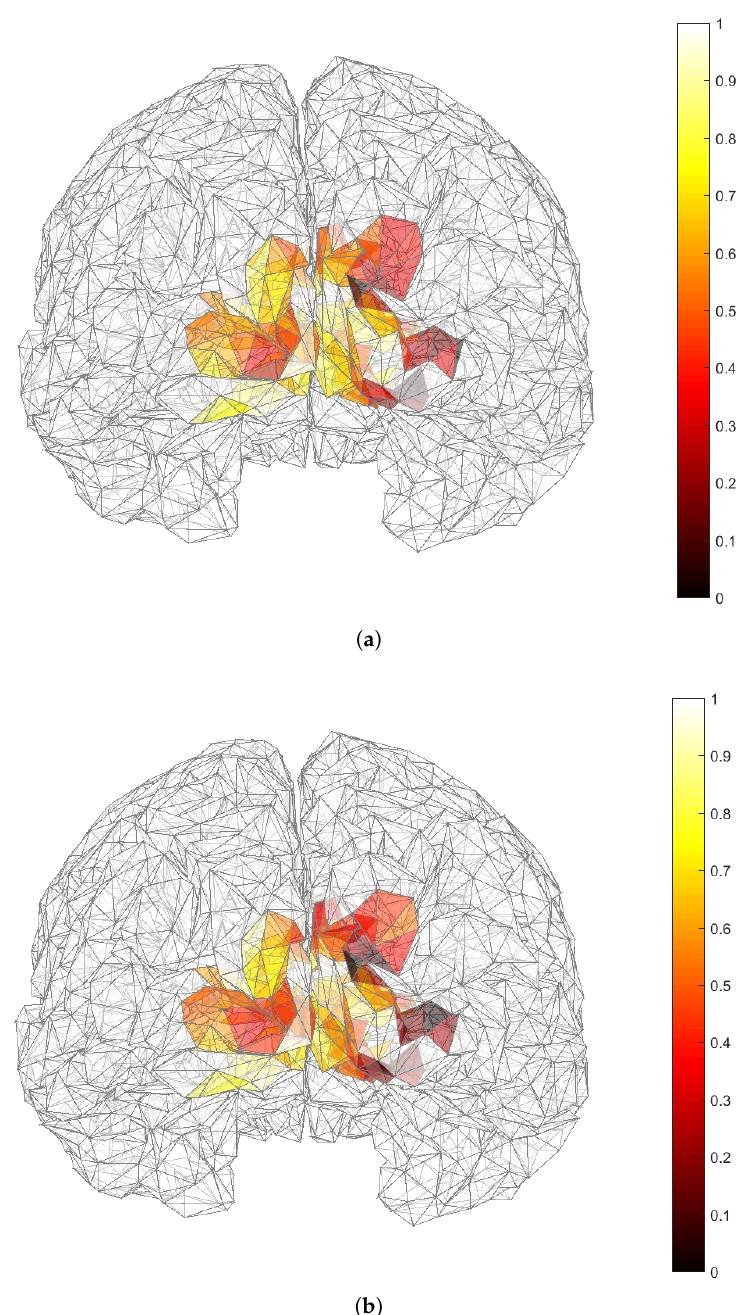
Figure 8. Results of the source localization process through our reduced-rank beamforming approach in EEG SSVEP data of Subject 5 in [27] and for a specific frequency. Minimum values of ι in darker colors) correspond to zones of main brain activation. ( a ) ι